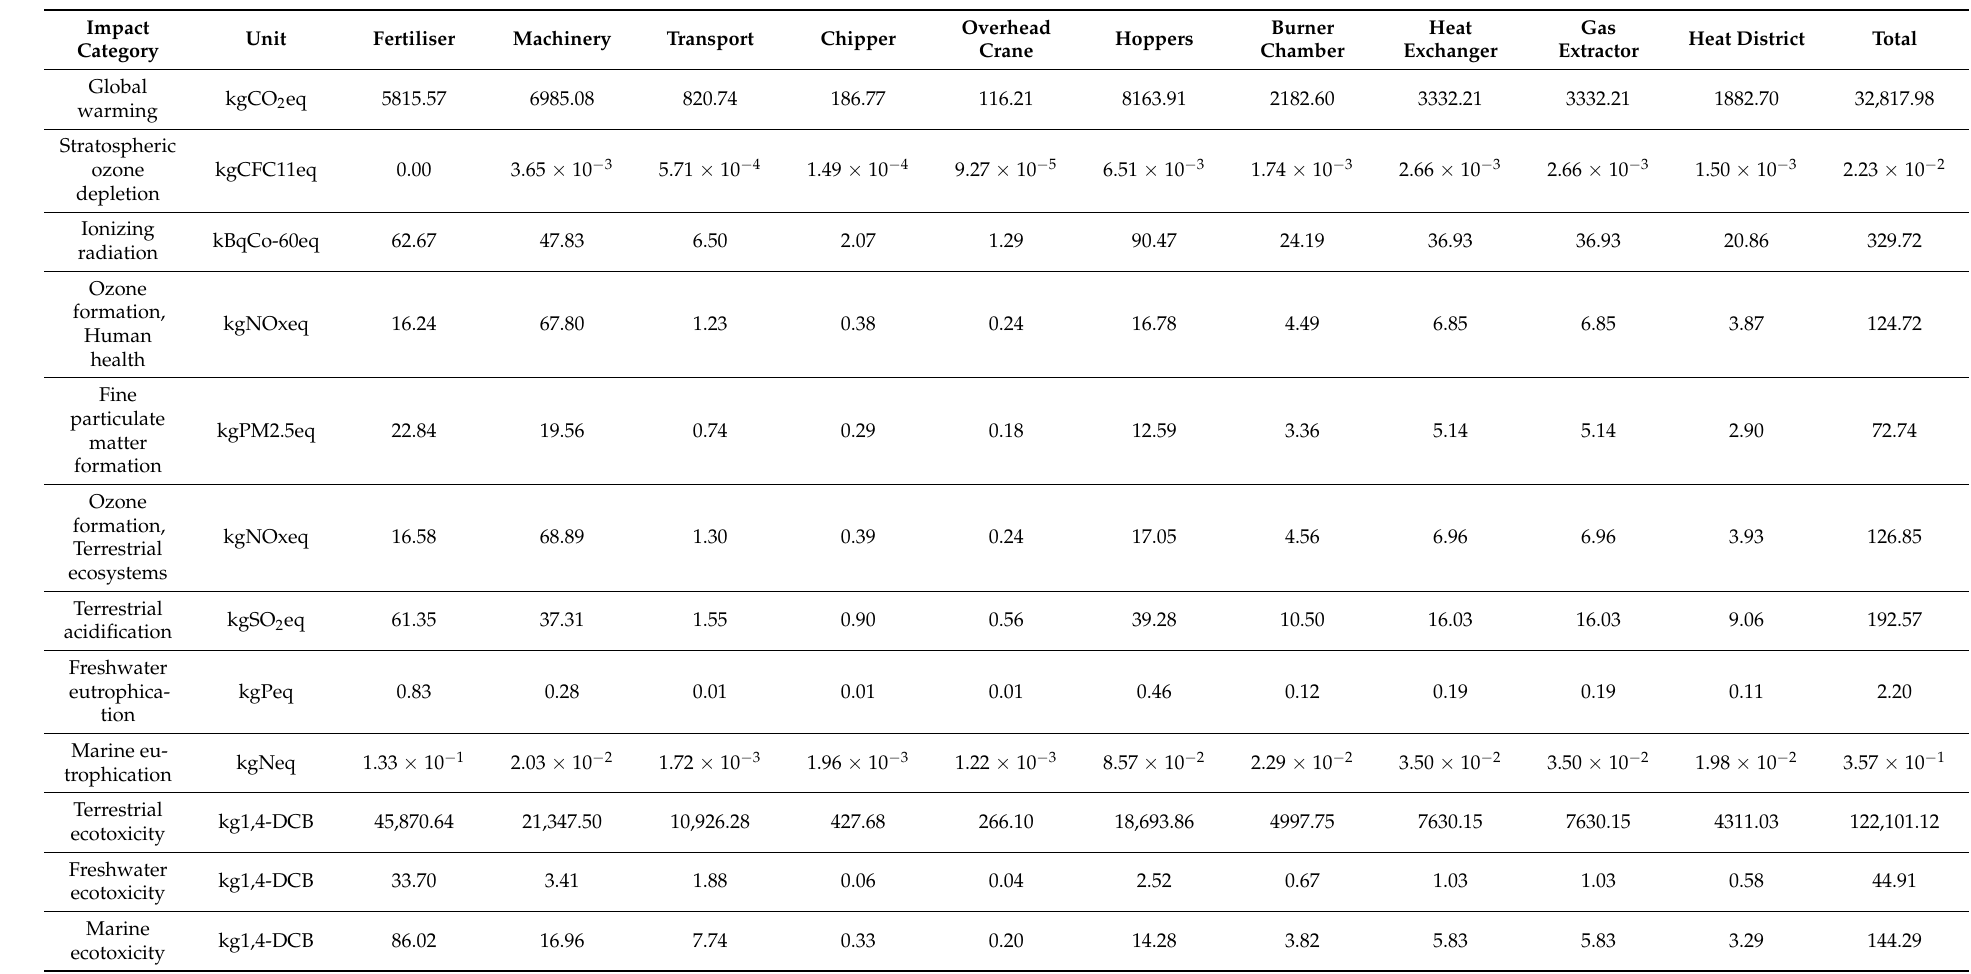
Table A1. ReCiPe Midpoint—characterisation—polygeneration